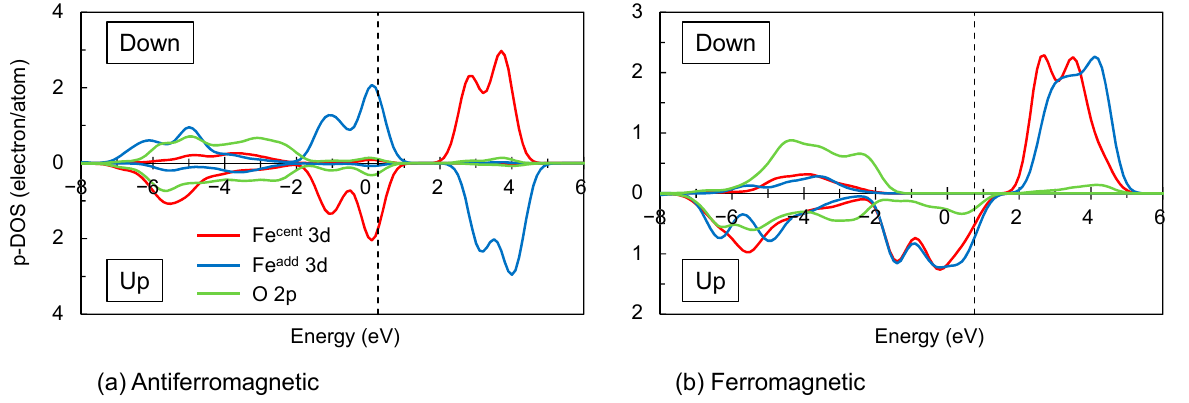
Figure 6. Partial density of states of the Fe 3d and O 2p orbitals in γ -LiAlO 2 :Fe 3+ . The dashed lines indicate the HOMO energies. The profiles were drawn with the Gaussian width of 0.3 eV. Fe cent : Fe atom at the center, Fe add : additional Fe atom.